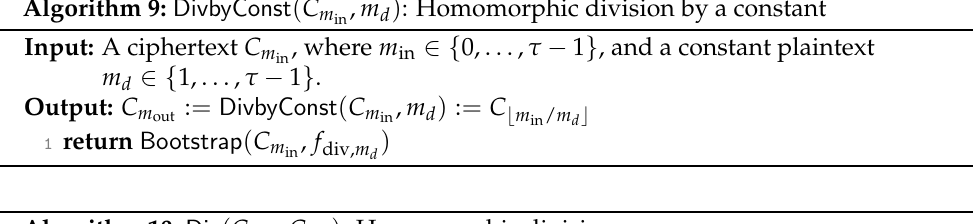
Algorithm 10: Div ( C m